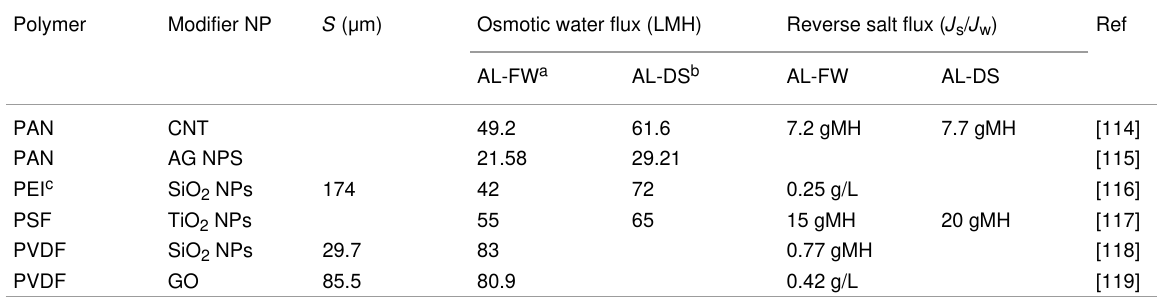
Table 3: Recently developed electrospun nanohybrid membranes for forward osmosis.